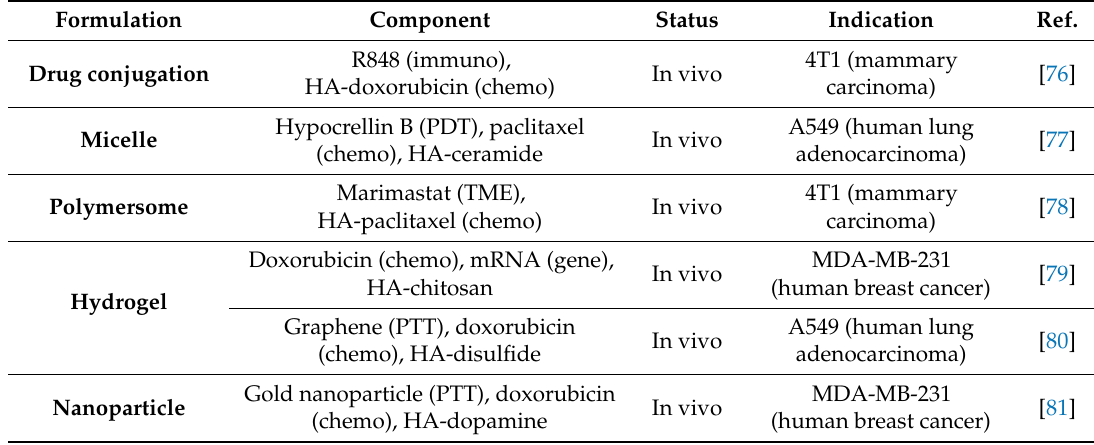
Table 4. Summary of recent principal research for combination therapy using HA-based nanomaterials.